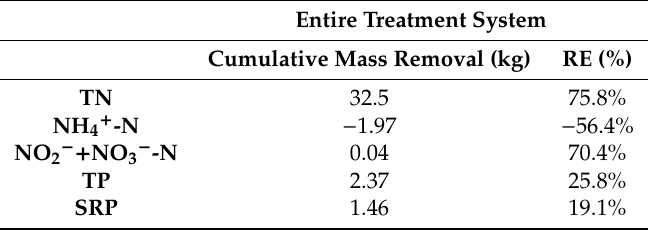
Table 2. Cumulative mass removal of nitrogen (N) and phosphorus (P) mass loads and overall removal efficiency (RE %) in 2019 for 15 storm events where loads were calculated, between System Inflow and Combined Bioreactor Outflow (i.e., from East and West Bioreactor Outflows). Negative values indicate an export of nutrient. TN = total N, NH 4+ -N = ammonium-N, NO 2 - +NO 3 - -N = nitrite + nitrate-N, TP = total P, SRP = soluble reactive P.